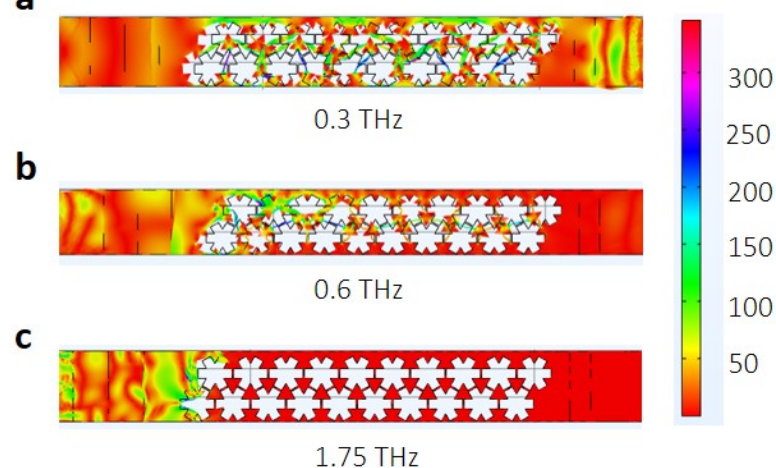
Figure 6. The transmission map, which analyses the transmission of the phonons with a particular frequency through the snowflake phononic crystal. The transmission characteristics for phononic frequencies of 0.3 THz, 0.6 THz, and 1.75 THz are shown in ( a ), ( b ) and ( c ) respectively. High transmission probability is observed for 0.3 THz waves. For 0.6 THz, the transmission probability is reduced significantly while for 1.75 THz, a complete phonon blockade is observed.